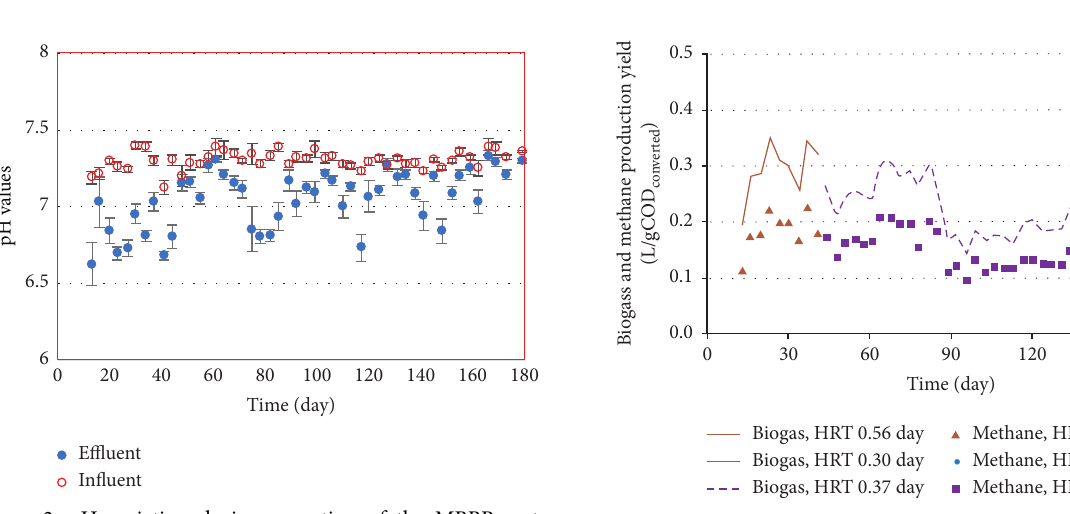
Figure 3: Biogas and methane production yield at different HRTs.